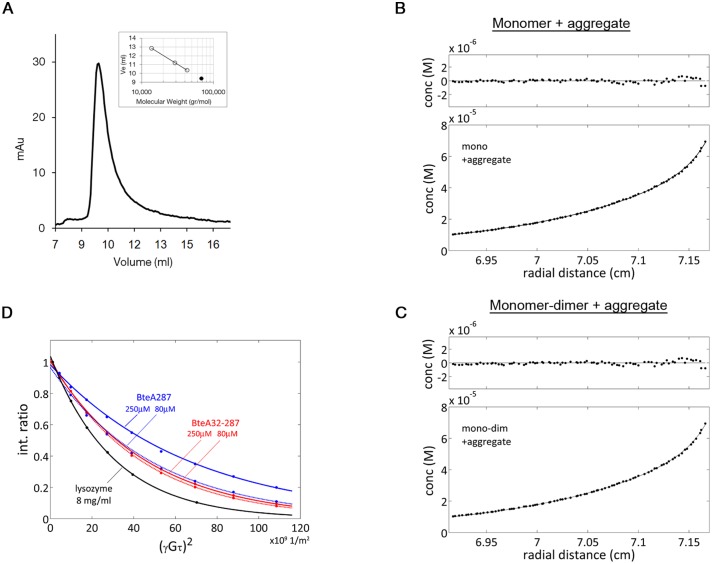
Size and oligomeric form of BteA287.(A) Size exclusion chromatogram of BteA287 demonstrates a single population. The elution volume of BteA287 combined with the calibration curve (inset) indicates an empirical molecular weight of 68 kDa (black point indicates the elution volume of BteA287 along the curve). (B, C) Bottom, sedimentation equilibrium curve for a 1 mg·ml−1 (30 µM) BteA287 sample at 15,000 rpm and 298 K in buffer containing 100 mM NaCl, 20 mM Tris pH 8. The curve was fit to a model assuming either a single monomeric species or monomer-dimer equilibrium, in both cases in the presence of a high-MW aggregate. Top, residuals of the fit. Calculated mass was 34,500 Da. (D) LED-BPP-based experiments were acquired to estimate the translational diffusion coefficient of BteA at 298 K. The decrease in intensity of methyl region signals is plotted against (γGτ)2, where γ is the proton gyromagnetic ratio (2.67·108 T−1s−1), G is the applied magnetic gradient field and τ is the total length of the bipolar gradient, 4.8 ms in these experiments. Using the literature value of Ds = 11.1·10−11 m2s−1 for lysozyme (black) the value of G at maximal strength was determined as 0.514 Tm−1. Curves shown are for 250 µM BteA287 (solid blue), 80 µM BteA287 (dotted blue), 250 µM BteA32-287 (solid red), and 80 µM BteA32-287 (dotted red). In the case of BteA287, mono-exponential fits can be significantly improved using a bi-exponential fit, indicating the presence of aggregation for the longer protein.